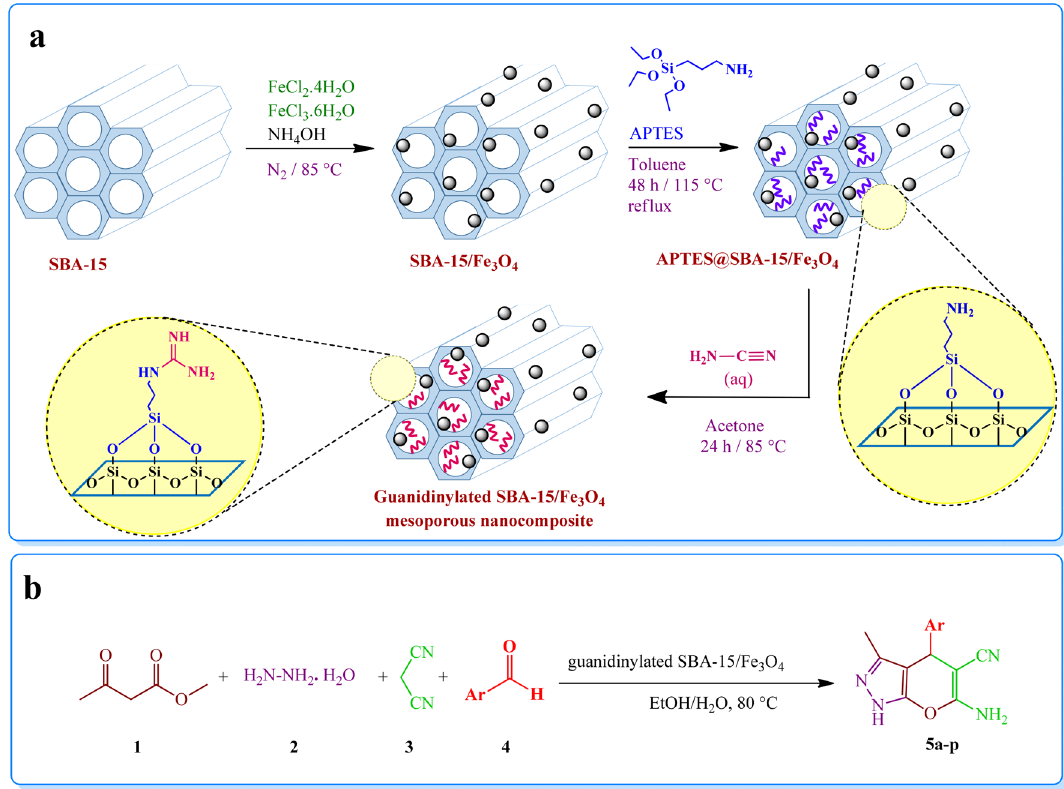
Figure 1. Preparation route of ( a ) the guanidinylated SBA-15/Fe 3 O 4 and ( b ) its catalyst application in the synthesis of dihydropyrano[2,3-c]pyrazole